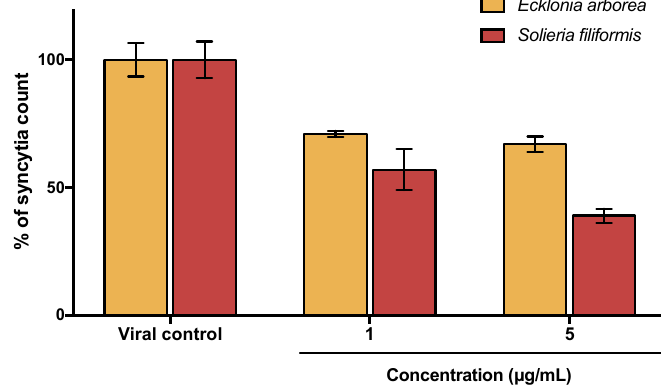
Figure 5. Effect of PPs on viral penetration. Vero cells were infected with MeV at 4 °C in the absence of PPs and then shifted to 37 °C to permit penetration of the adsorbed virus in the presence of PPs. Syncytia count is given in % of the untreated control values. Each bar represents the average of three replicates.